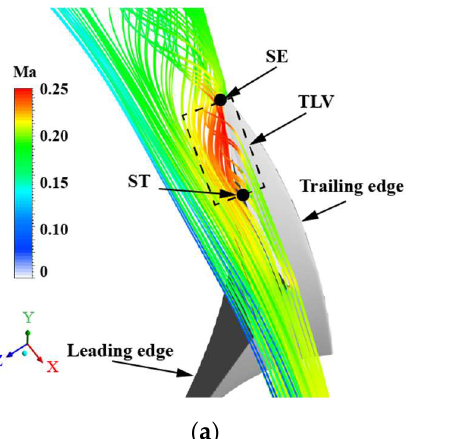
Figure 17. Comparison of streamline distribution and Mach contour near the endwall: ( a ) flow characteristic near the endwall; ( b ) ORI; ( c ) MES; ( d ) MOS; ( e ) MPS.